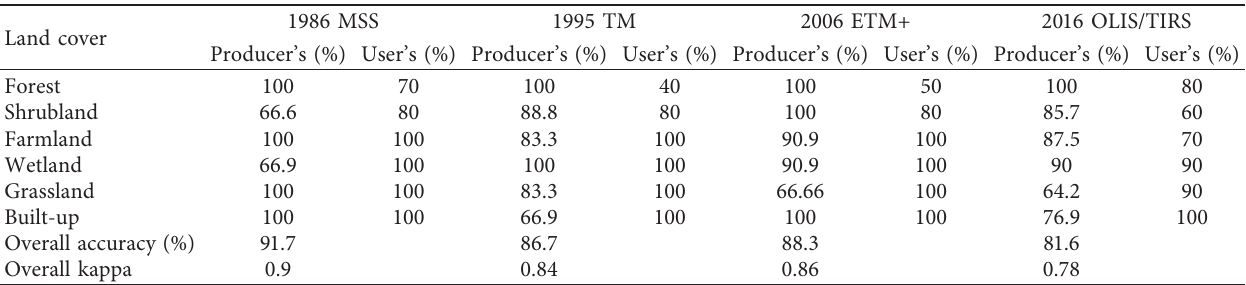
Table 2: Image classification accuracy assessment for the different images. All assessments are in percentage.